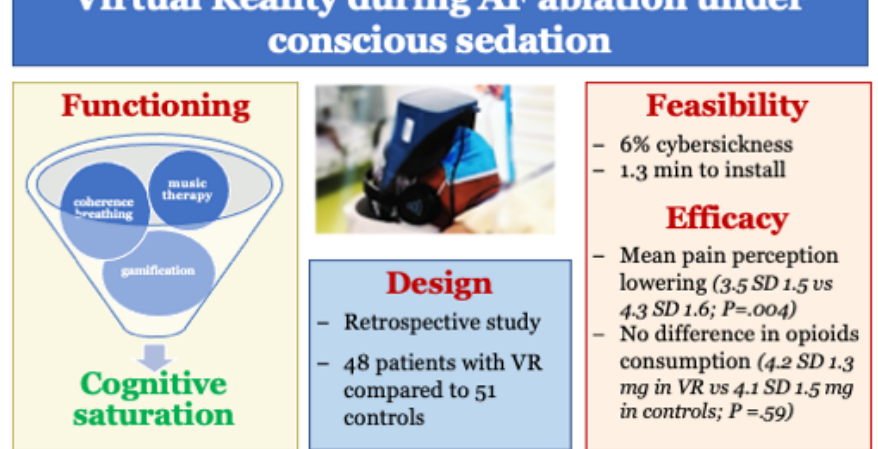
Figure 1. Virtual reality (VR) use during atrial fibrillation (AF)